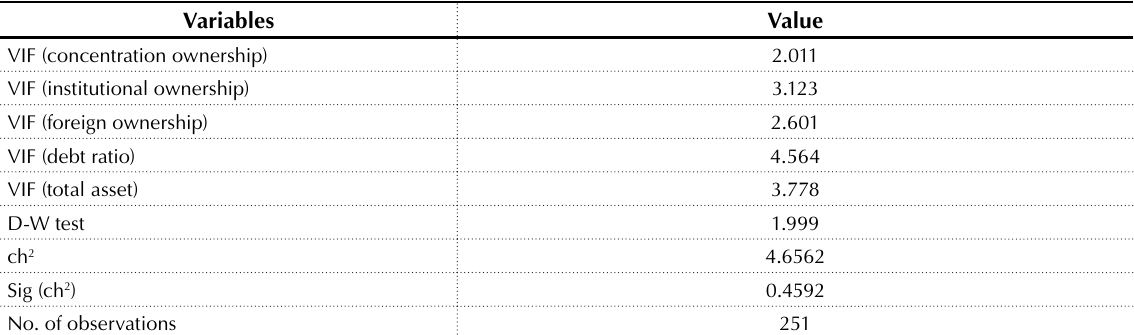
Table 1. Relevance of study data according to regression